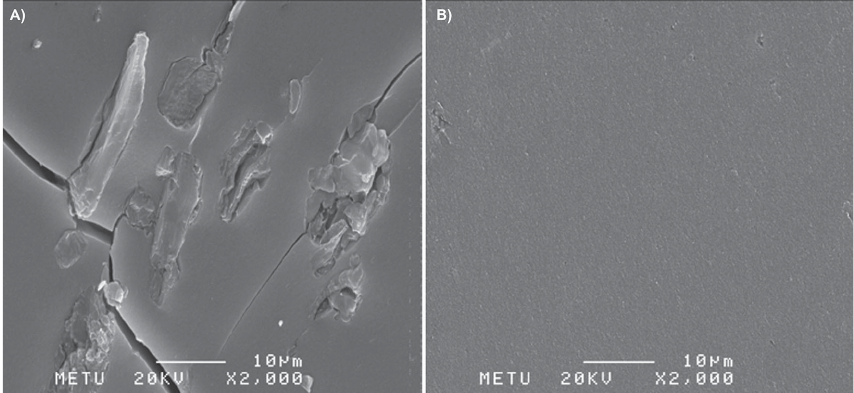
FIGURE 3 - Scanning electron micrographs of cross sections of F2 coded chitosan microspheres: (A), before dissolution test and after 24 hours from dissolution test